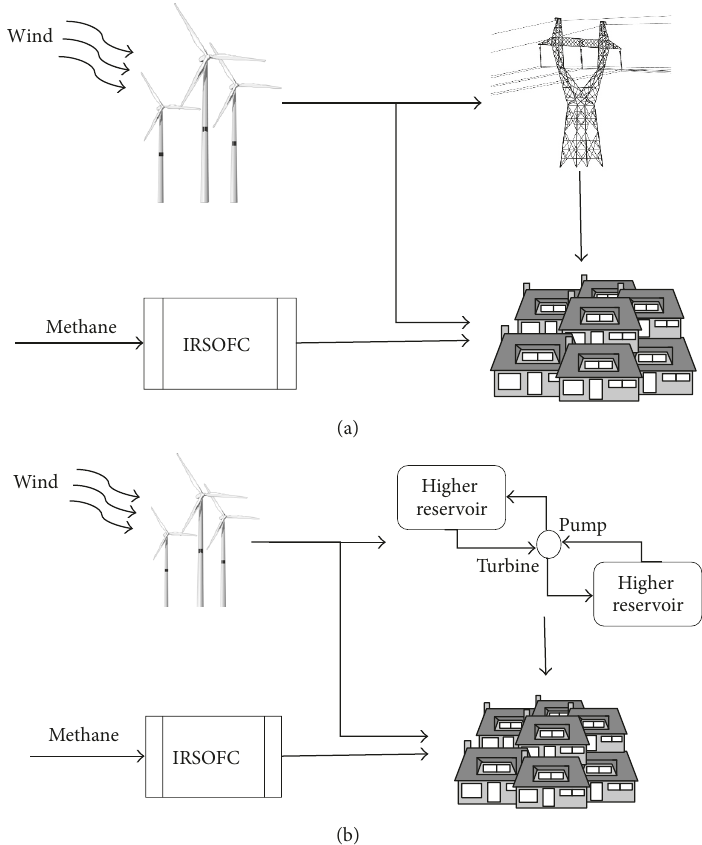
Figure 1: Schematic of the system: (a) first scenario and (b) second